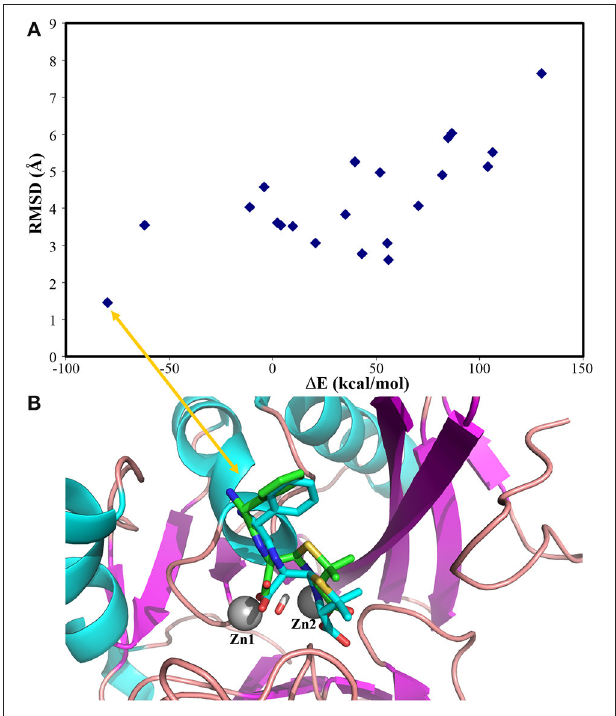
FIGURE 2 | the predicted conformations of hydrolysed ampicillin with NDM-1 using the Docking/QM method vs. its crystal structure (PDB 3Q6X, Zhang and Hao, 2011). (A) Correlation of binding energies 1 E and the RMSD of the predicted conformations with the crystal structure; (B) the overlay the predicted structure with lowest DE (blue) with the crystal structure (green) from PDB 3Q6X (Zhang and Hao, 2011). Figure was prepared using PyMol (Schrodinger,